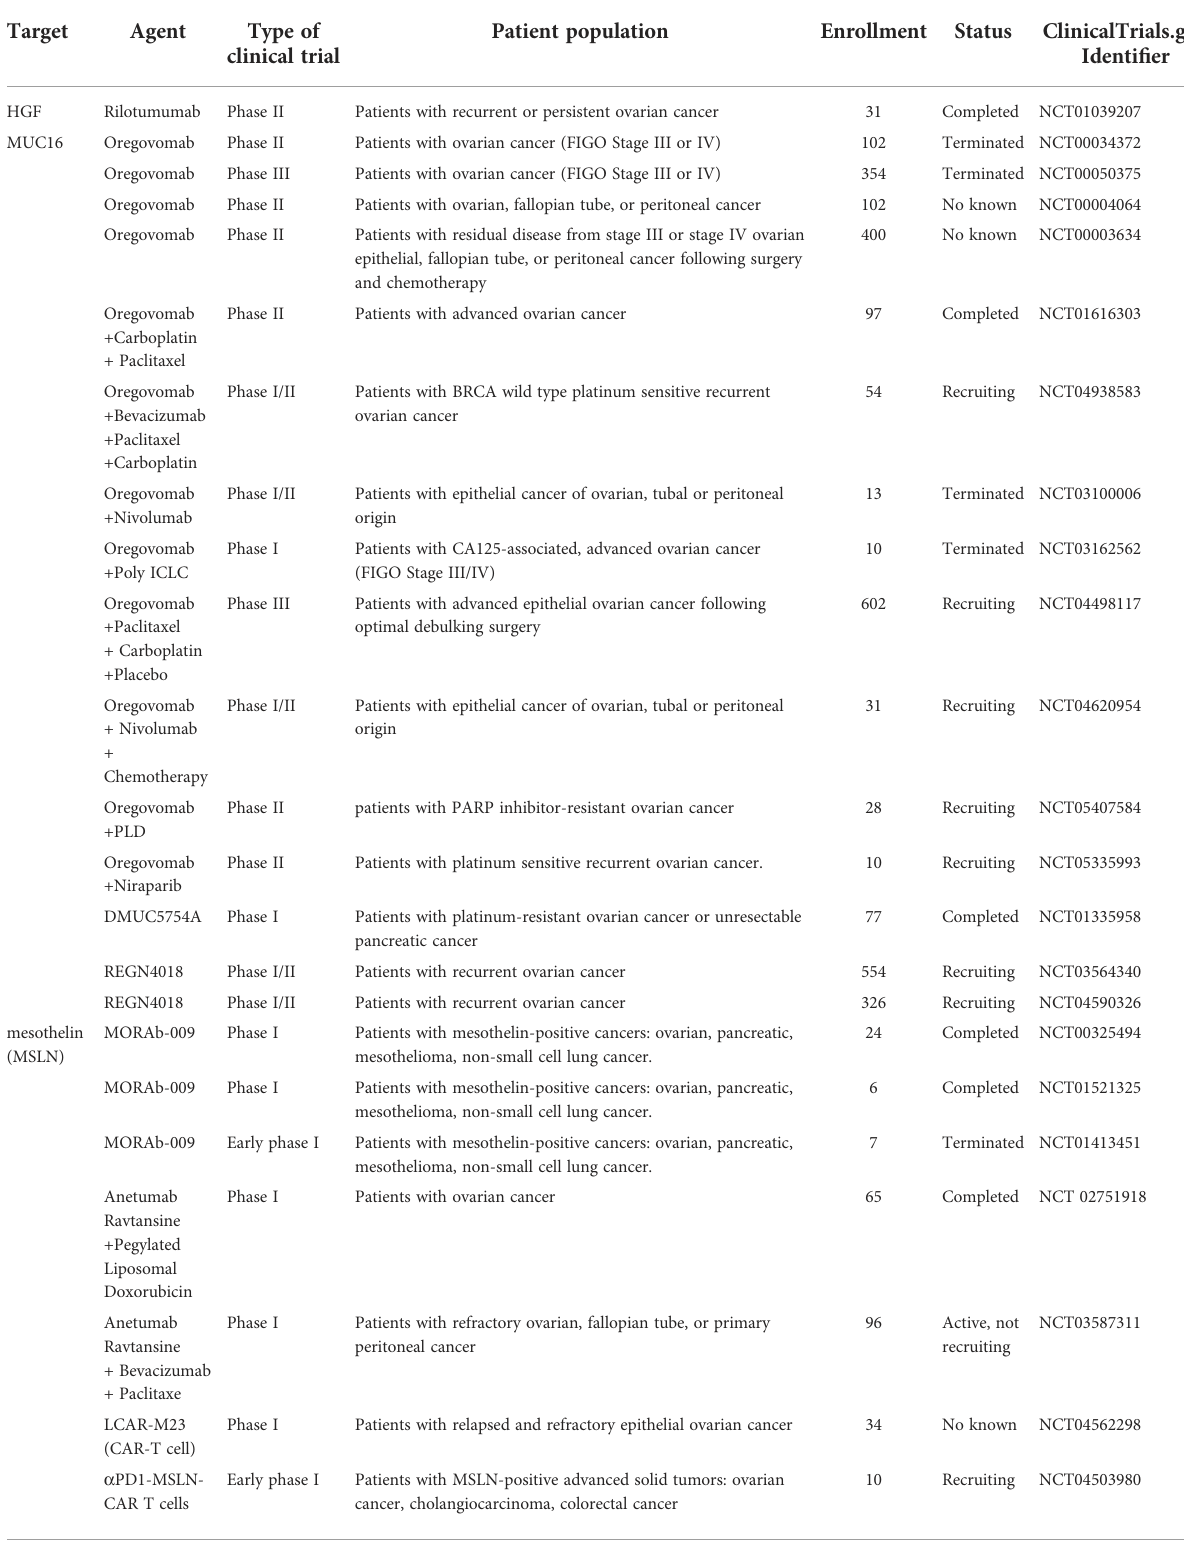
TABLE 1 Summary of clinical trials using MUC16-mesothelin (MSLN) and FN - a 5 b 1 integrin targeted